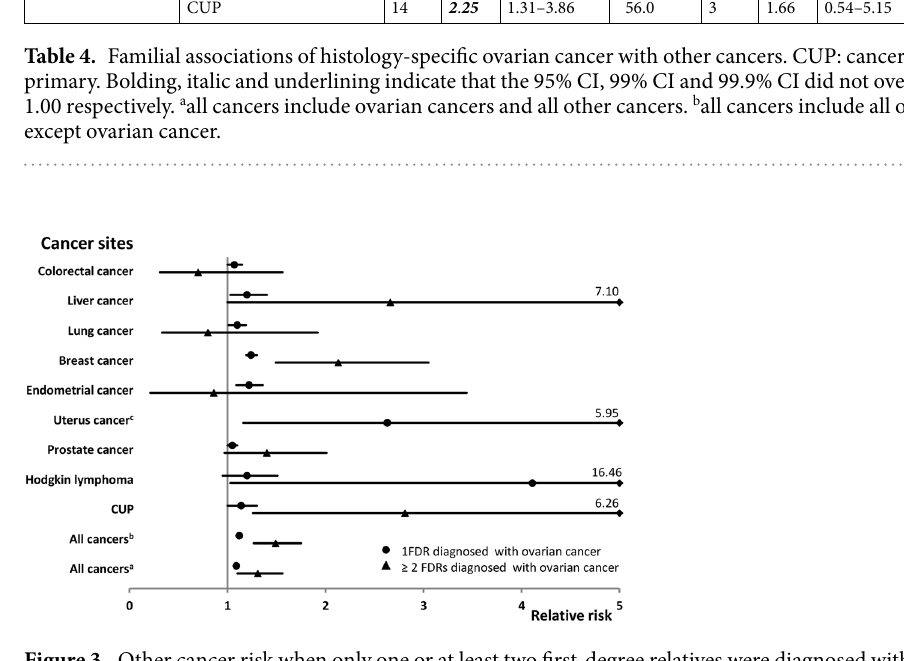
some specific histological types are associated only with specific cancers. Endometrial cancer was only associated with endometrioid ovarian cancer and this pair showed the most significance (RR > 2.00, joint P < 10 − 6 ) among all the histology-based associations. Most endometrioid ovarian cancers were synchronous with endometrial